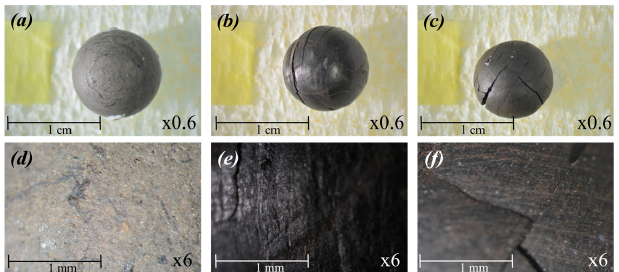
Figure 8. The samples used in: ( a ) Test 1; ( b ) Test 2; and ( c ) Test 3. Magnified pictures of the surfaces in: ( d ) Test 1; ( e ) Test 2; and ( f ) in Test 3.